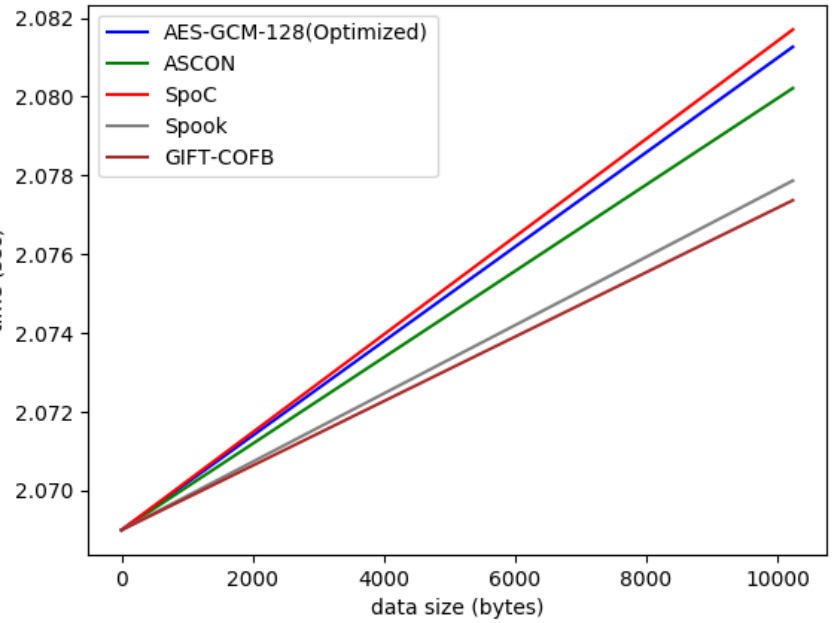
Figure 5. The processing time of the proposed D2D communication system.